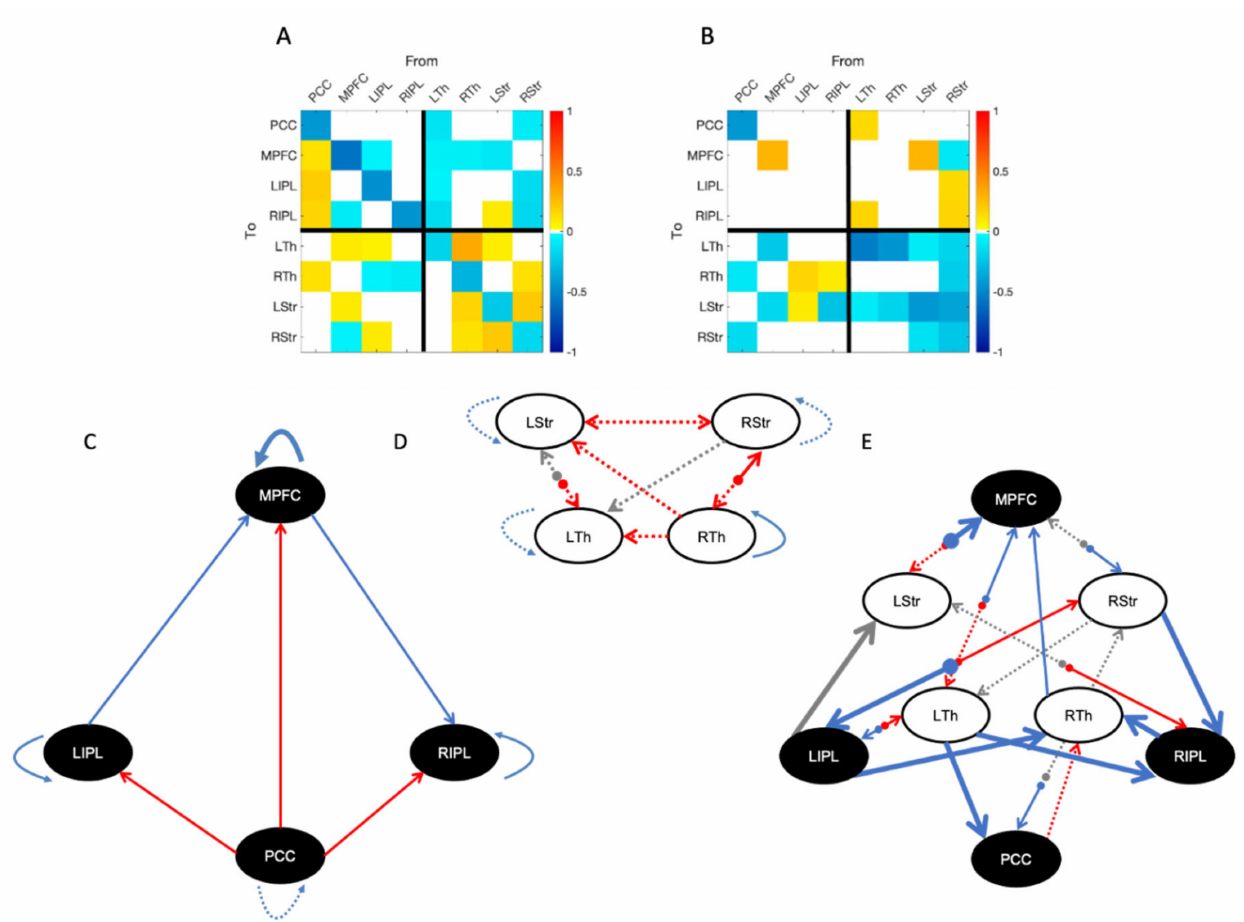
Figure 2. Group mean effective connectivity in healthy controls ( A , C – E ) and differences with PDOC patients ( B – E ). We only display connections present in the reduced model (>95% posterior probability for free energy). The top two panels, ( A , B ), show the mean parameter strength (Ep.A) for the healthy controls mean and the difference between them and PDOC, respectively. Note that self-connections are always inhibitory meaning a positive self-connection parameter in B indicates that PDOC have stronger self-inhibition compared to healthy controls (negative being the opposite). ( C , D ) show schematic representations of the results in the matrix in B separately for the DMN ( C ), the anterior forebrain mesocircuit (AFM) ( D ), and the extrinsic connections between them ( E ). Note that this is only to facilitate visualization, but all regions were part of the model space in our analysis. The color of the line refers to its tone in the healthy control mean: red lines represent excitatory connections, and blue represent inhibitory. Grey lines show connections that did not contribute to the healthy control mean model but showed differences between them and PDOC. The format of the line represents the differences between groups: a dashed line represents reduced coupling in PDOC and a thick line shows stronger coupling in PDOC. For self-connections, dashed lines represent reduced self-inhibition and thicker lines increased self-inhibition. PCC, posterior cingulate cortex/precuneus; MPFC, medial prefrontal cortex; LIPL, left inferior parietal lobule; RIPL, right inferior parietal lobule; LTh, left thalamus; RTh, right thalamus; LStr, left striatum; RStr, right